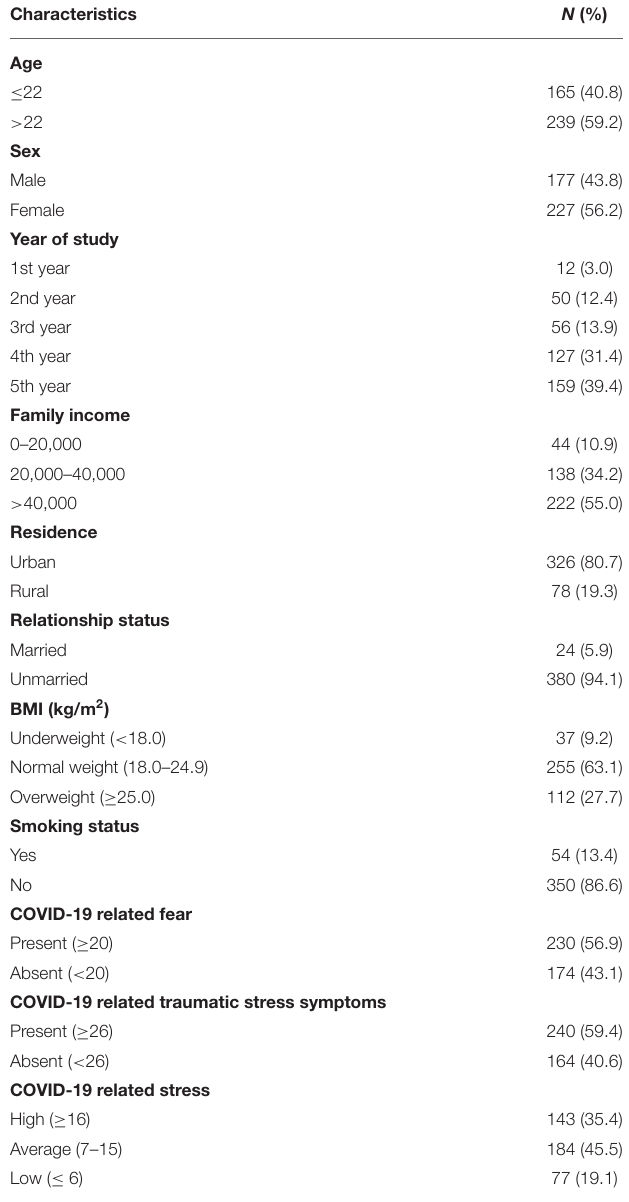
TABLE 1 | Sociodemographic characteristics and COVID-19 pandemic-related stresses of the participants ( n = 404).